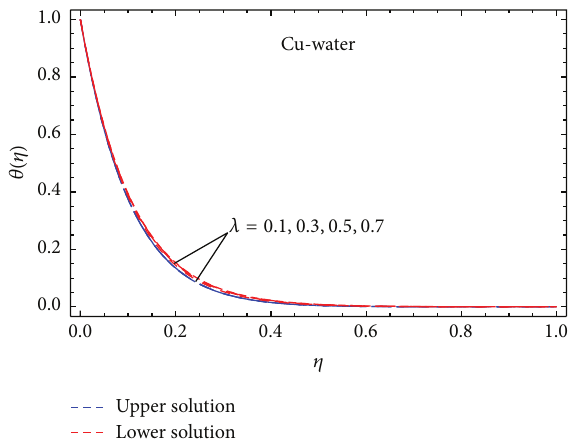
Figure 13: Dual temperature for several values of 𝜆 at 𝑠 = 2 , 𝜙 = 0.1 , and 𝑀 = 1.5 .